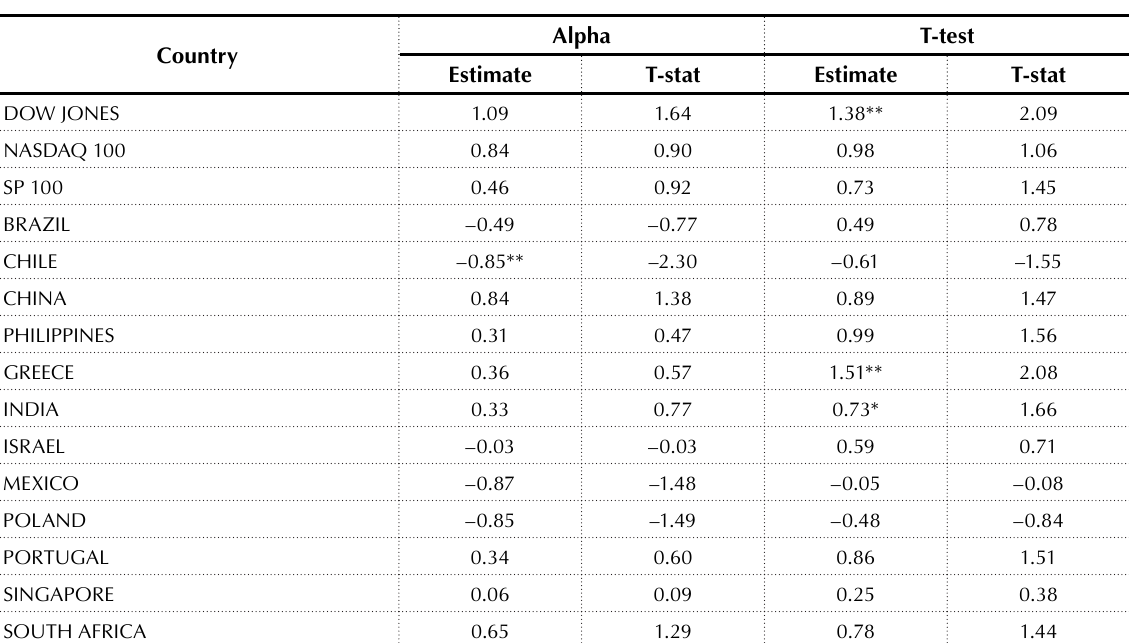
Panel B. Statistical